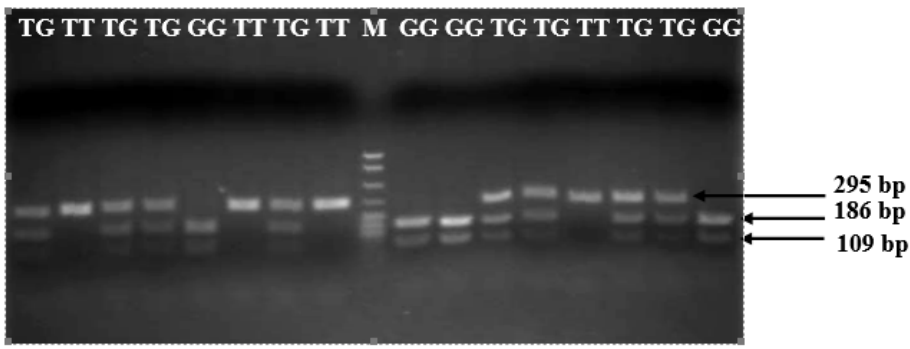
Figure 2. The polymorphism of the TLR2 gene. GG, GT, and TT indicate the genotypes, and M in- dicates the leader. Bp: base pairs. indicates the leader. Bp: base